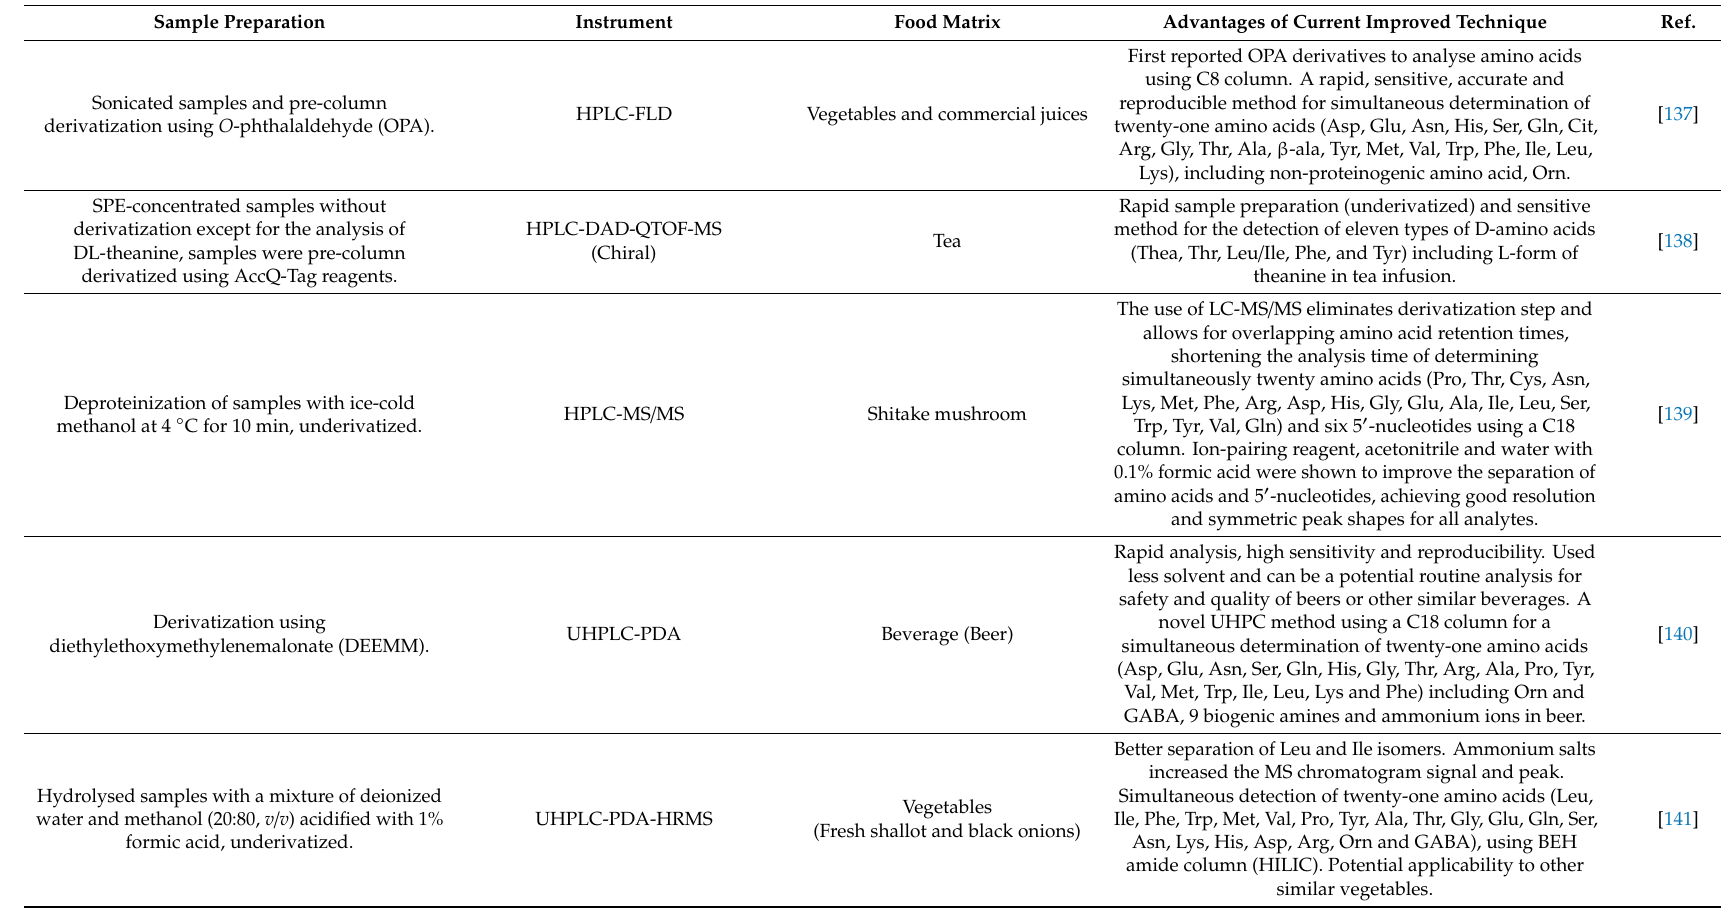
Table 5. Methods, food matrices and advantages of current improved technique for amino